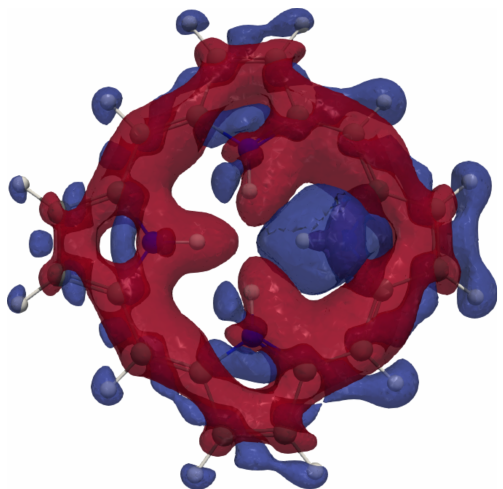
Figure 7. The isotropic 1 H NMR shielding density of the inner hydrogen of free-base isophlorin. The shielding contributions are shown in blue and the deshielding contributions in red. An isovalue of ± 0.04 has been used. The corresponding pictures of the 1 H NMR shielding densities of the β hydrogen atoms are given in the